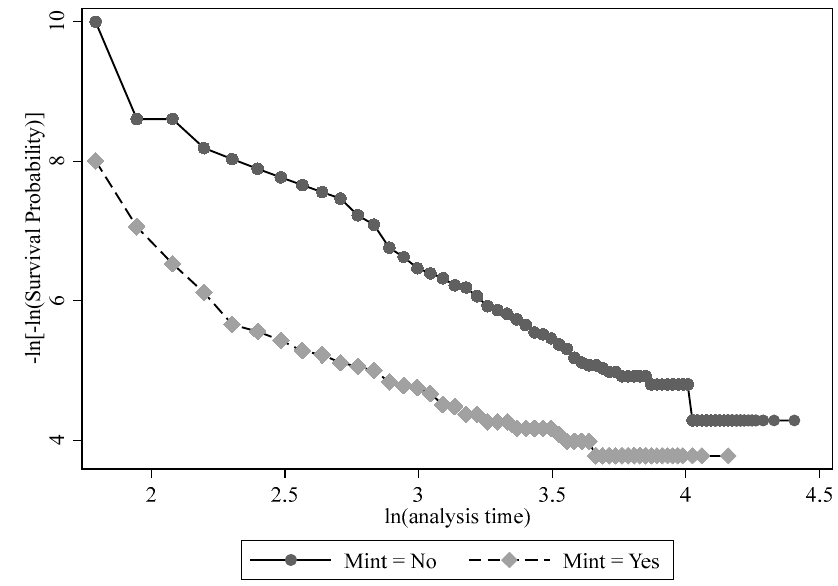
Figure 3. Assessment of proportional hazards assumption for Internet access.